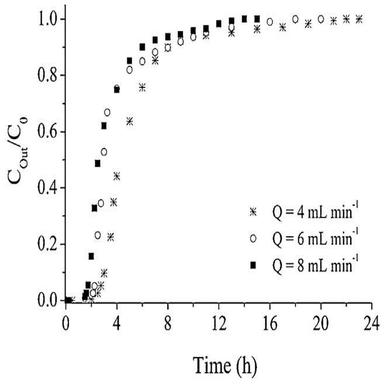
Influence of feed flow rate on the glyphosate adsorption in the fixed-bed column (mads = 5 g, HT = 10 cm, C0 = 20 mg L−1, pH ≈ 4.7 e T ≈ 25 ◦C).